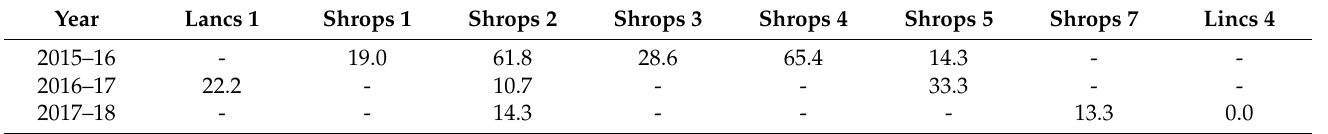
Table 5. Temporal stability of higher density slug patches at the 11 study sites in which a GLM mixed effects model detected consistent effects of trap location on number of slugs caught between data matrices generated by assessments taken on different dates. Tables show ( A ) the percentage of permutations of pairs of data matrices at each study site in which a significant correlation between the pairs of matrices was recorded and ( B ) the percentage of permutations in which a significant correlation between the pairs of matrices was not recorded but one or both assessments were taken when slug surface activity resulted in mean catches of <4 slugs per trap.